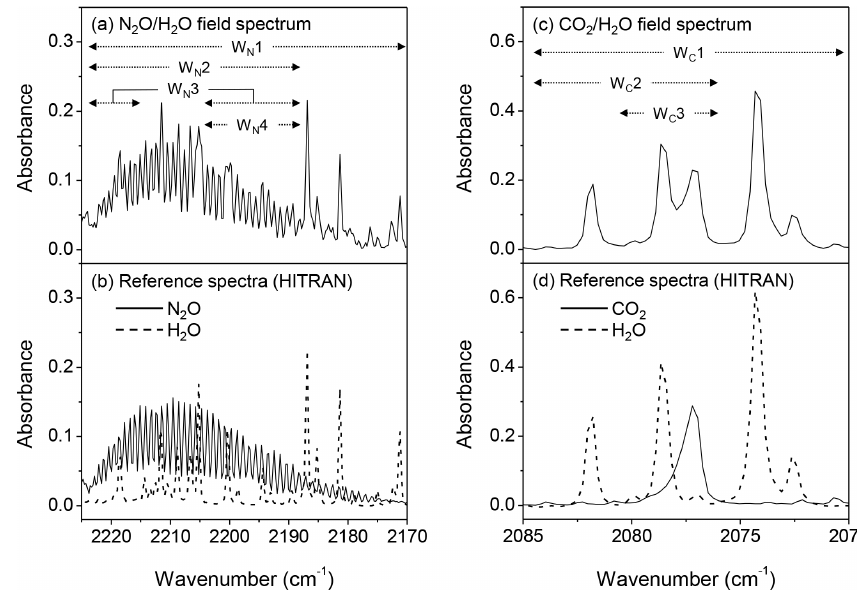
Figure 4. Field and HITRAN reference absorbance spectra: (a) field spectrum containing the features of N 2 O and water vapour, (b) reference spectra of N 2 O and water vapour at 2170.0–2224.0cm − 1 , (c) field spectrum containing the features of CO 2 and water vapour, and (d) refer- ence spectra of CO 2 and water vapour at 2070.0–2084.0cm − 1 . W N (1–4) and W C (1–3) denote the spectral windows used to calculate N 2 O and CO 2 concentrations from field